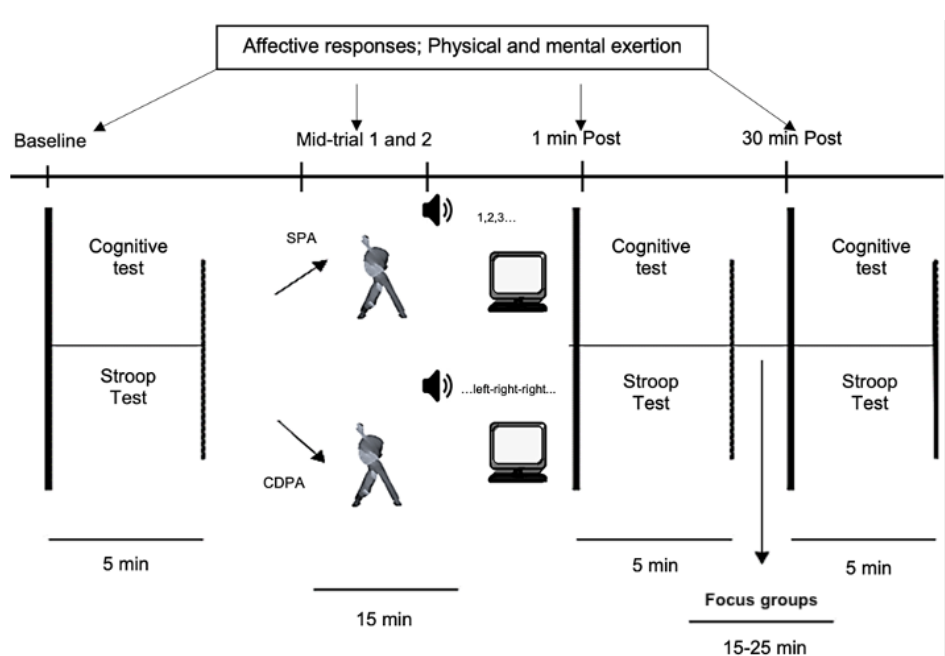
Figure 1. The time course and procedure for the SPA and CDPA conditions.